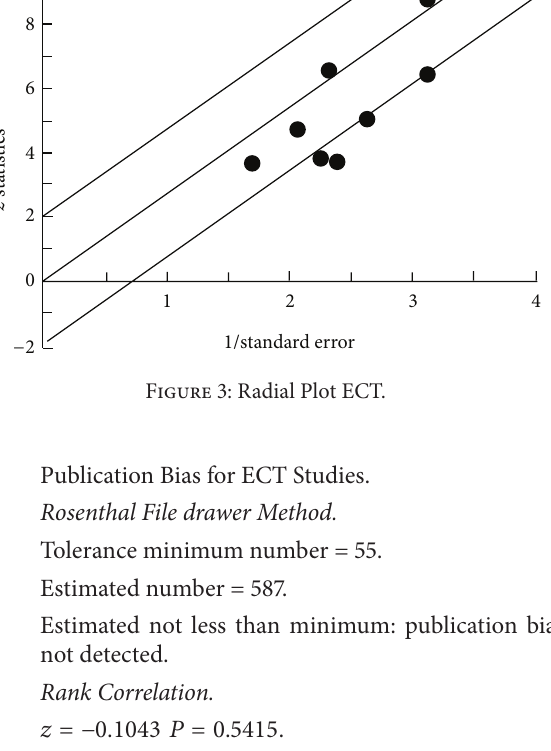
Figure 2: Forrest Plot rTMS.